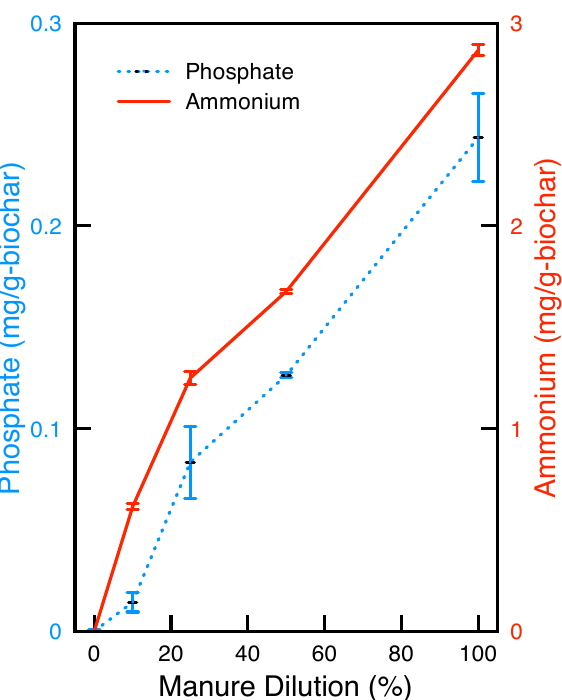
Figure 3. Amount of biomass produced annually in counties in the state of California, US (Commission,